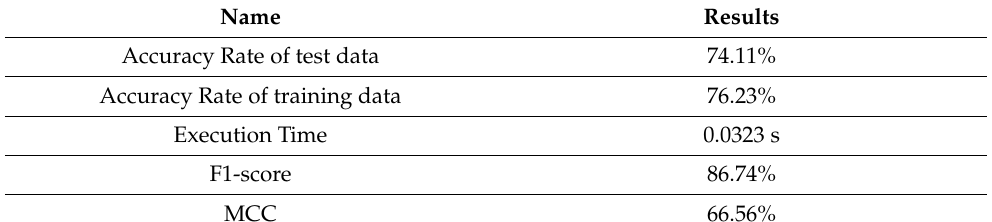
Table 4. Naïve Bayes Classifier Results.